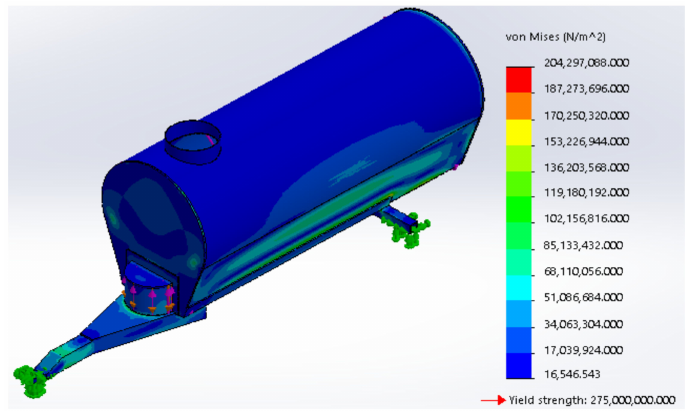
Figure 12. The stress distribution in the final design.